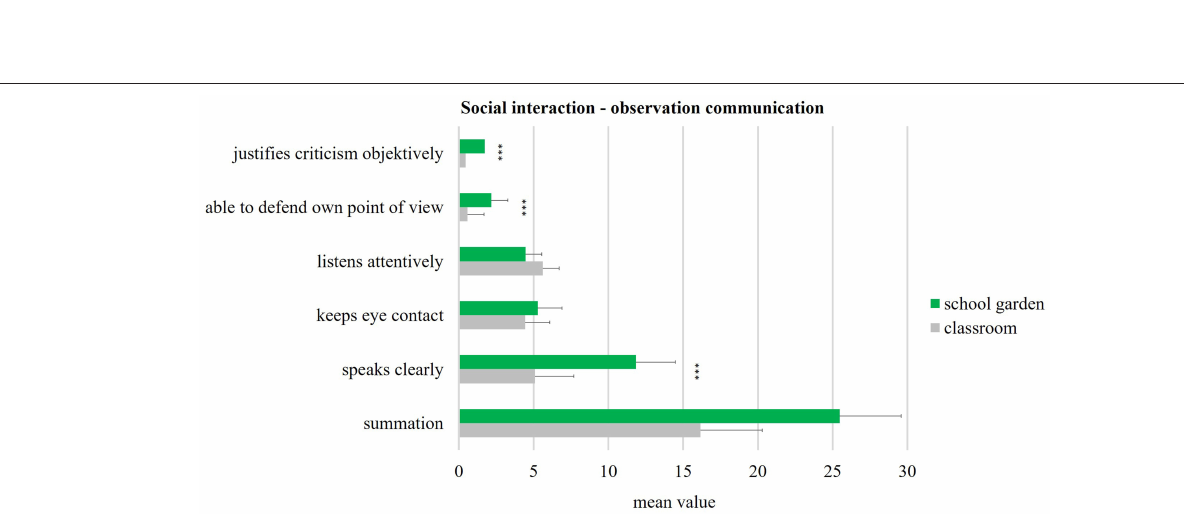
Frontiers in Psychology |